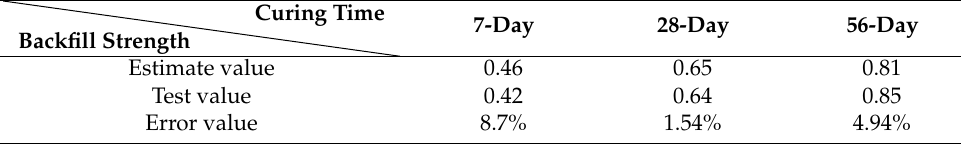
Table 8. Error analysis of confirmatory